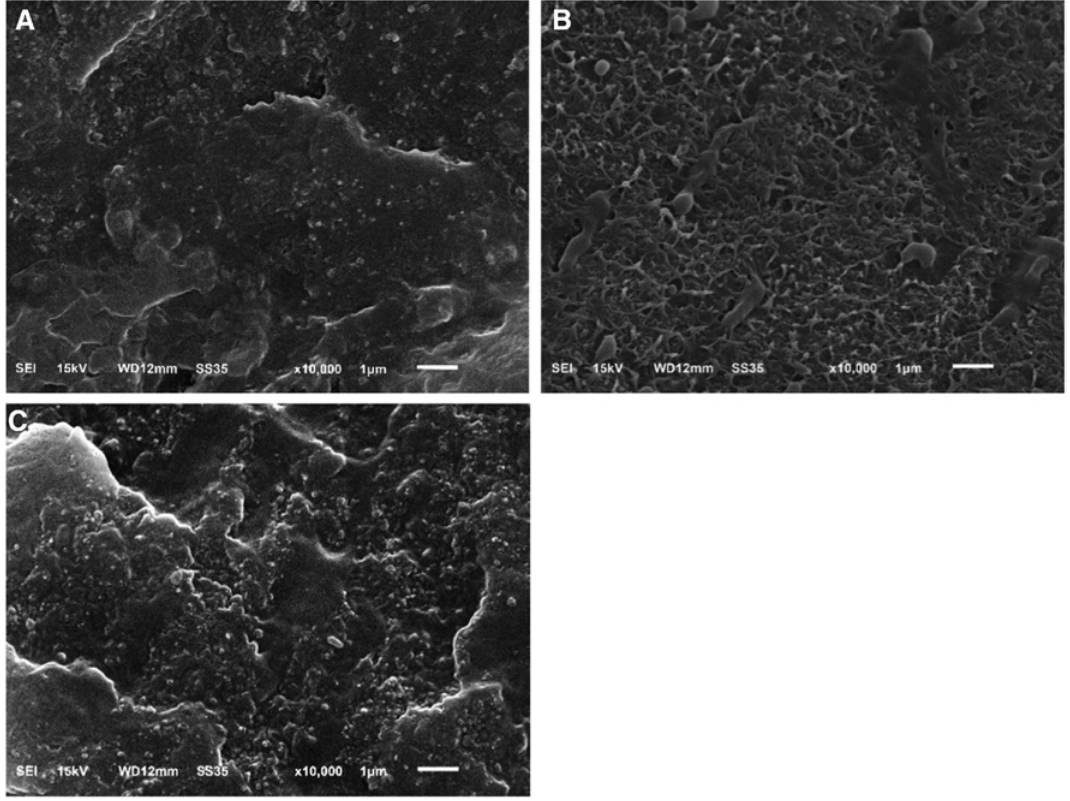
Figure 2: SEM micrographs of the LDPE/EVA/CB containing 15 wt% CB with different LDPE/EVA mass ratios: (A) LDPE/EVA = 100/0; (B) LDPE/ EVA = 80/20; (C) LDPE/EVA = 60/40.